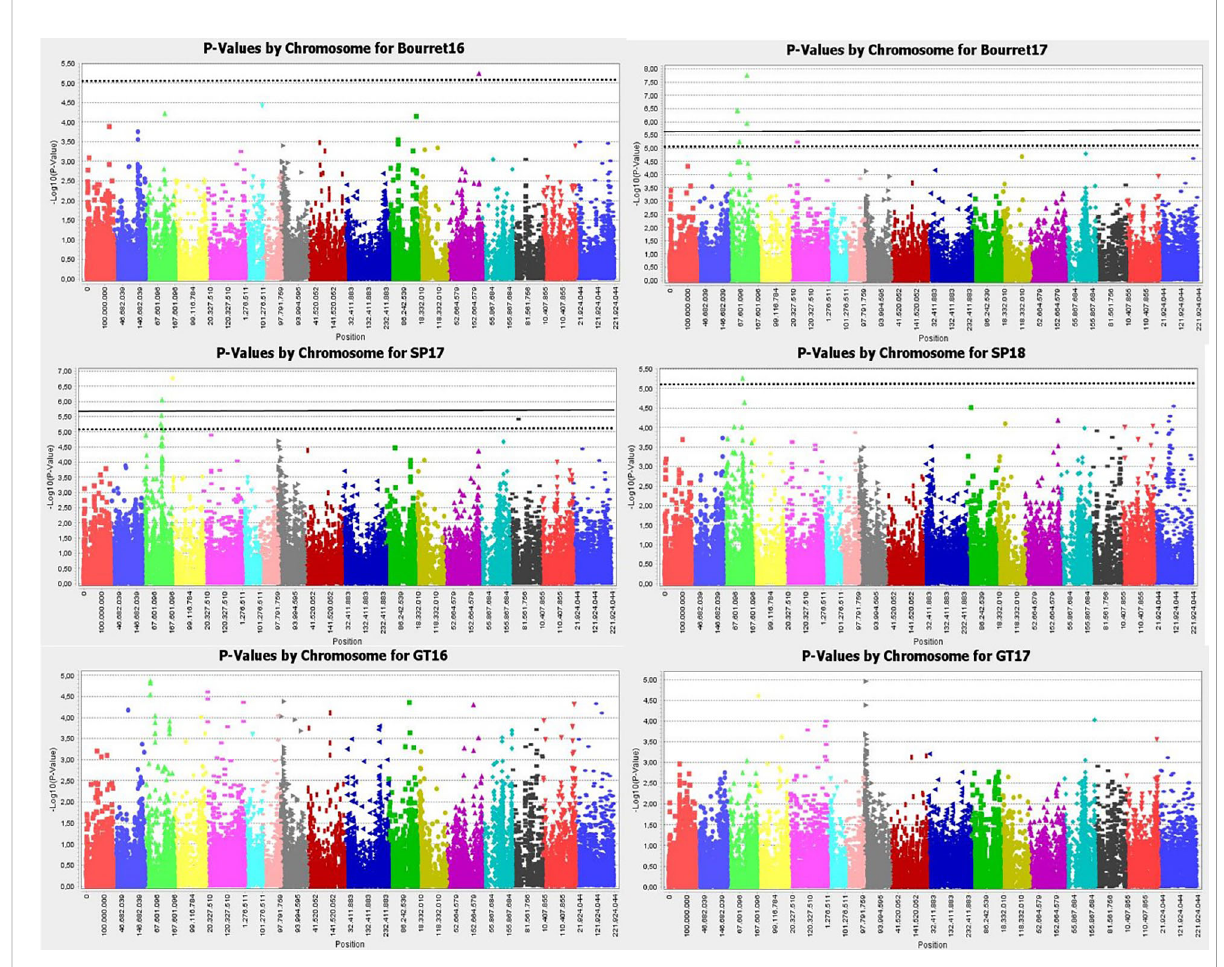
FIGURE 4 Manhattan-plots illustrating signi fi cant associations for resistance to three broomrape populations (SP, Bourret and GT) in a panel of 104 sun fl ower accessions evaluated in two environments each using GLM+PCA. The P values were adjusted using the Bonferroni threshold and false detection rate (FDR) correction (5% and 20%) to reduce false positive associations. The solid line corresponds to the 5% threshold and the dotted line to the 20% threshold. The vertical axis indicates – log10 of p-value and horizontal axis indicates chromosomes and physical positions of